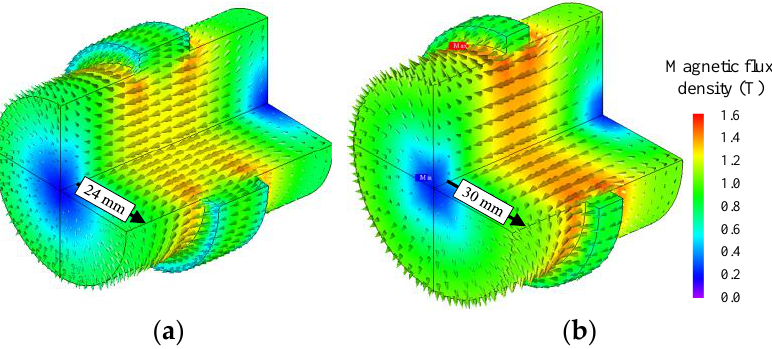
Figure 20. Analysis results of magnetic flux density: ( a ) prototype motor rotor shaft with i m of 10 A; ( b ) hybrid motor rotor shaft with i f of −4.2 A.